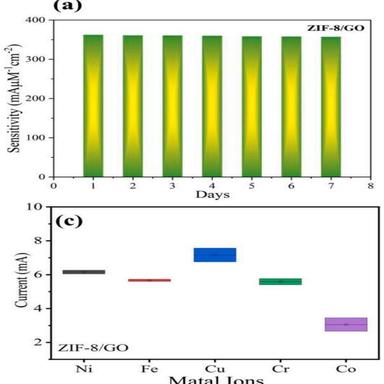
Plots of sensitivity versus days for (a) ZIF-8/GO, and (b) ZIF-8/rGO composites-based Cu2+ ions sensors. (c) Sensitivity versus different metal ions on ZIF-8/ GO composite-based Cu2+ ions sensors.